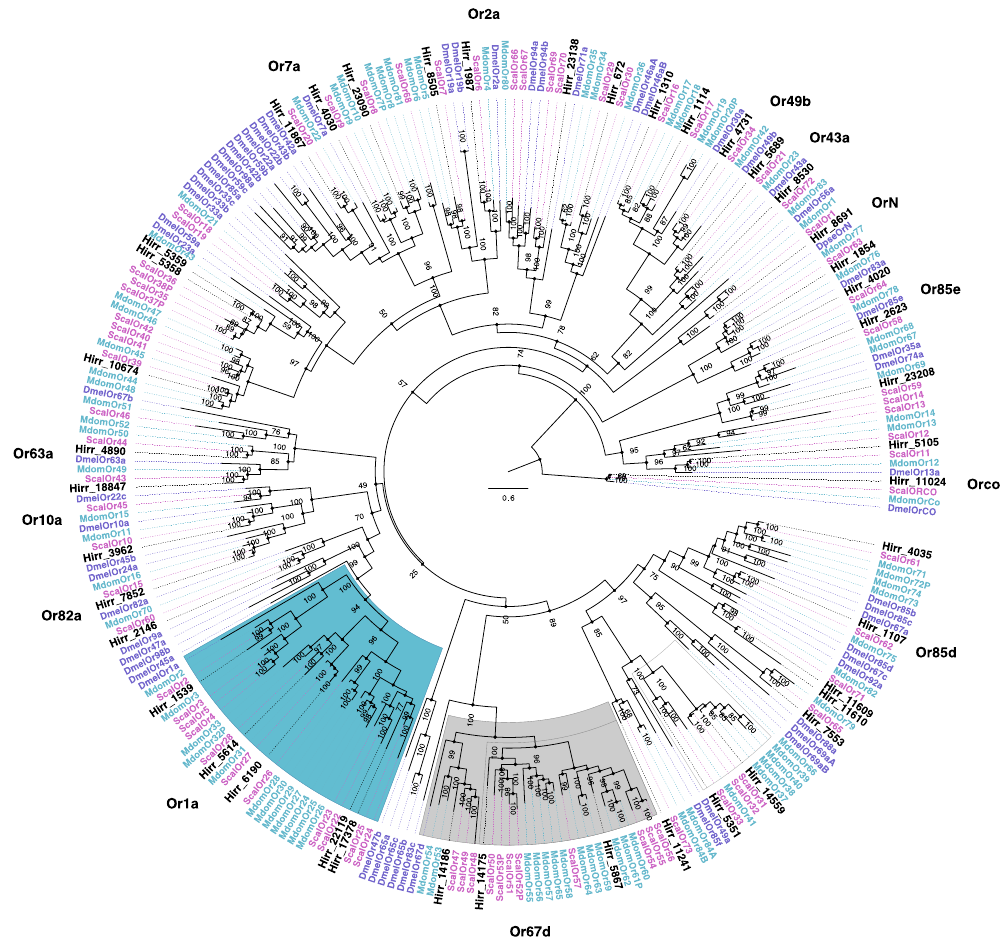
Figure 6. Phylogenetic relationship of Haematobia irritans candidate odorant receptors (OR) with those of Stomoxys calcitrans , Musca domestica, and Drosophila melanogaster . The H. irritans (Hirr) genes are labeled in black, while the S. calcitrans (Scal) and M. domestica (Mdom) genes are labeled in pink and teal, respectively. D. melanogaster (Dmel) genes are labeled in purple. Lineages that include apparent expansions in muscids relative to DmelOr67d and DmelOr1a are shaded in grey and teal, respectively. Individual Drosophila genes for which 1:1 horn fly candidate orthologues were identified are labeled on the edge to assist with finding them in the tree.